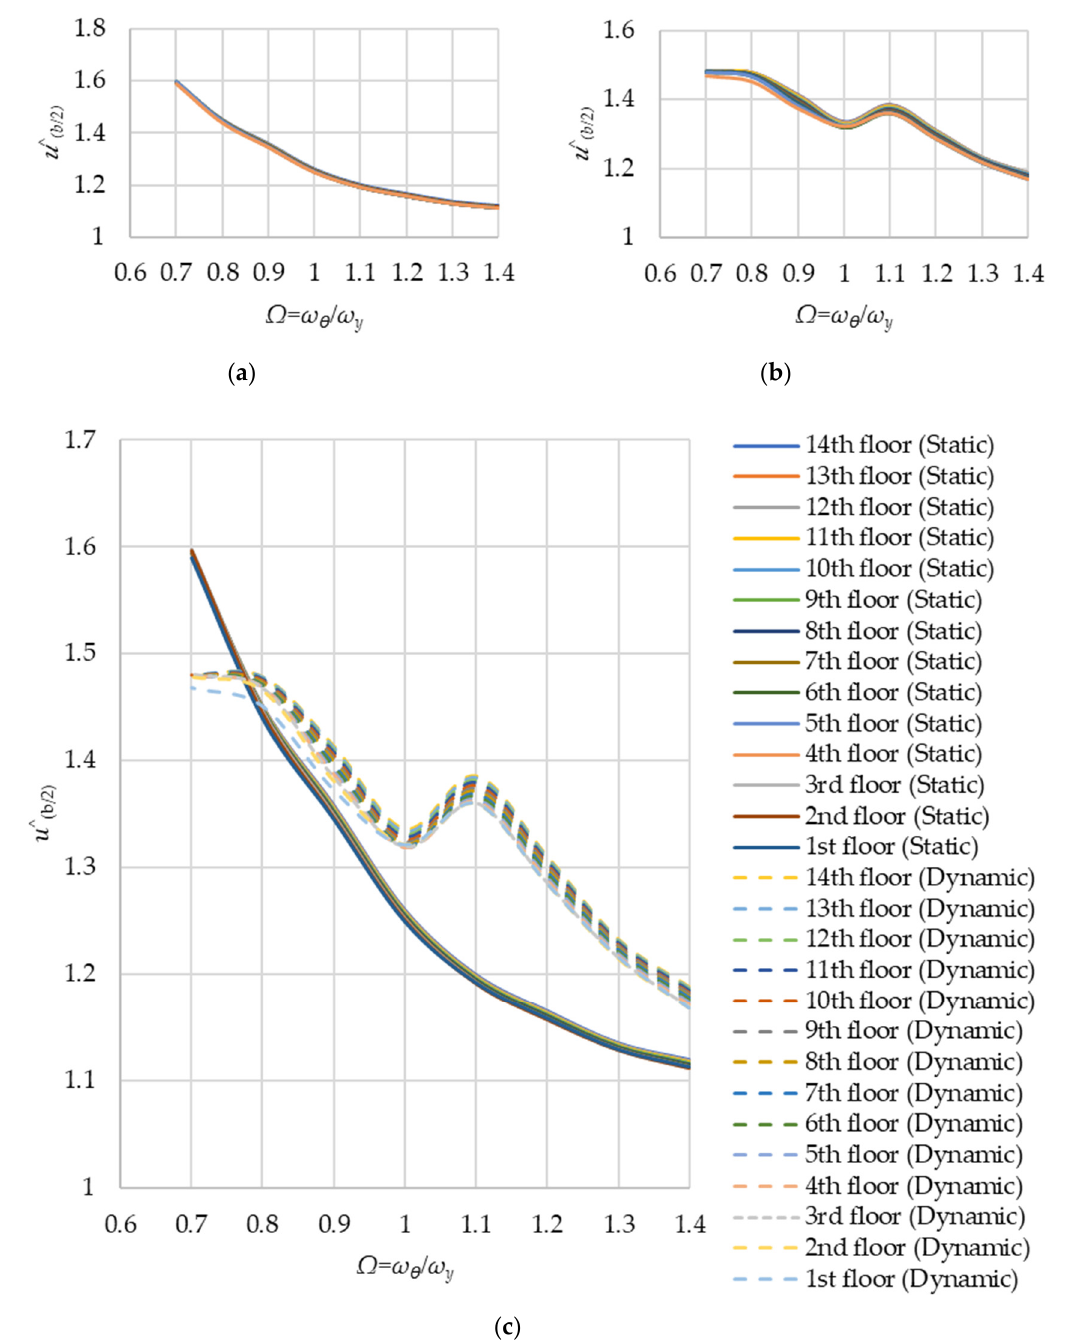
Figure 10. Normalized flexible edge displacement (with b / r = 1.4, Ty > 2 s): ( a ) Static edge displacement; ( b ) Dynamic edge displacement; ( c ) Static vs. dynamic edge displacement.